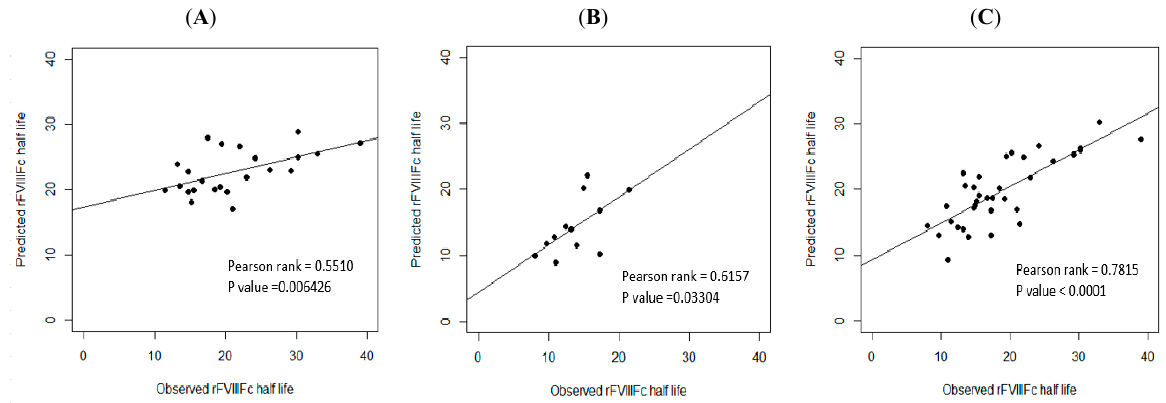
Figure 5. External validation. Correlation between the observed and predicted rFVIII-Fc half life values of the validation cohort: ( A ) for non-O group PwHA (n = 23) (P-rank = 0.5510, p -value < 0.01); ( B ) for O group PwHA (n = 12) (P-rank = 0.6157, p -value < 0.05); ( C ) for the entire cohort of PwHA (n = 35) (P-rank = 0.7815, p -value < 0.0001). The drawn lines show the best fit by univariate linear regression.